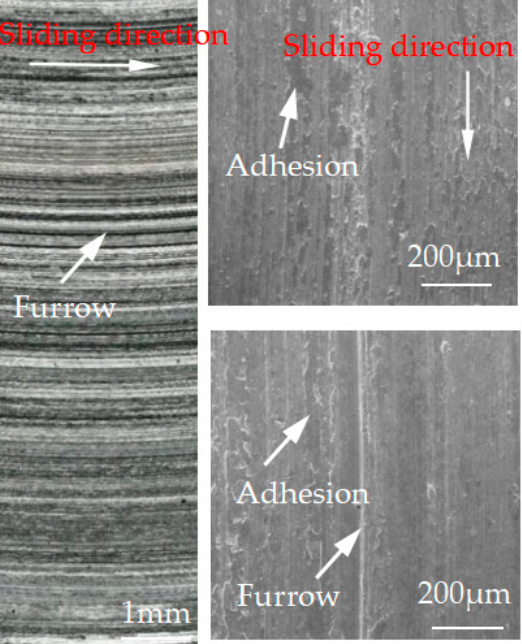
Figure 15. Surface morphology of the disc material after intermittent braking at an ambient temper- ature of − 20 °C.